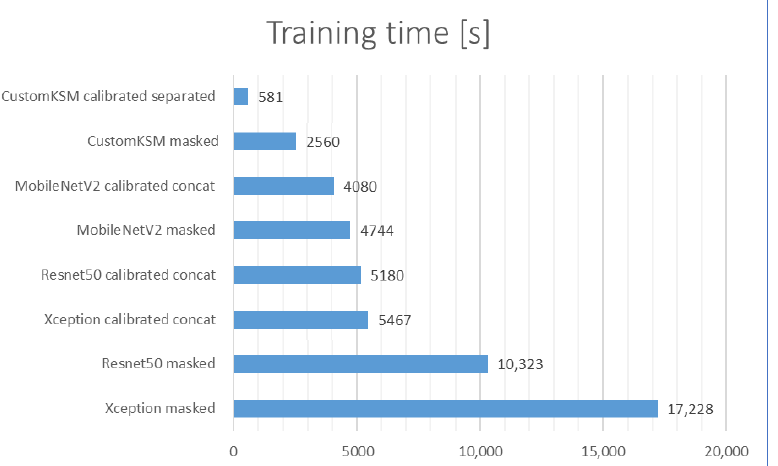
Figure 12. Training. times of the tested models on CPU (full dataset), the lower the